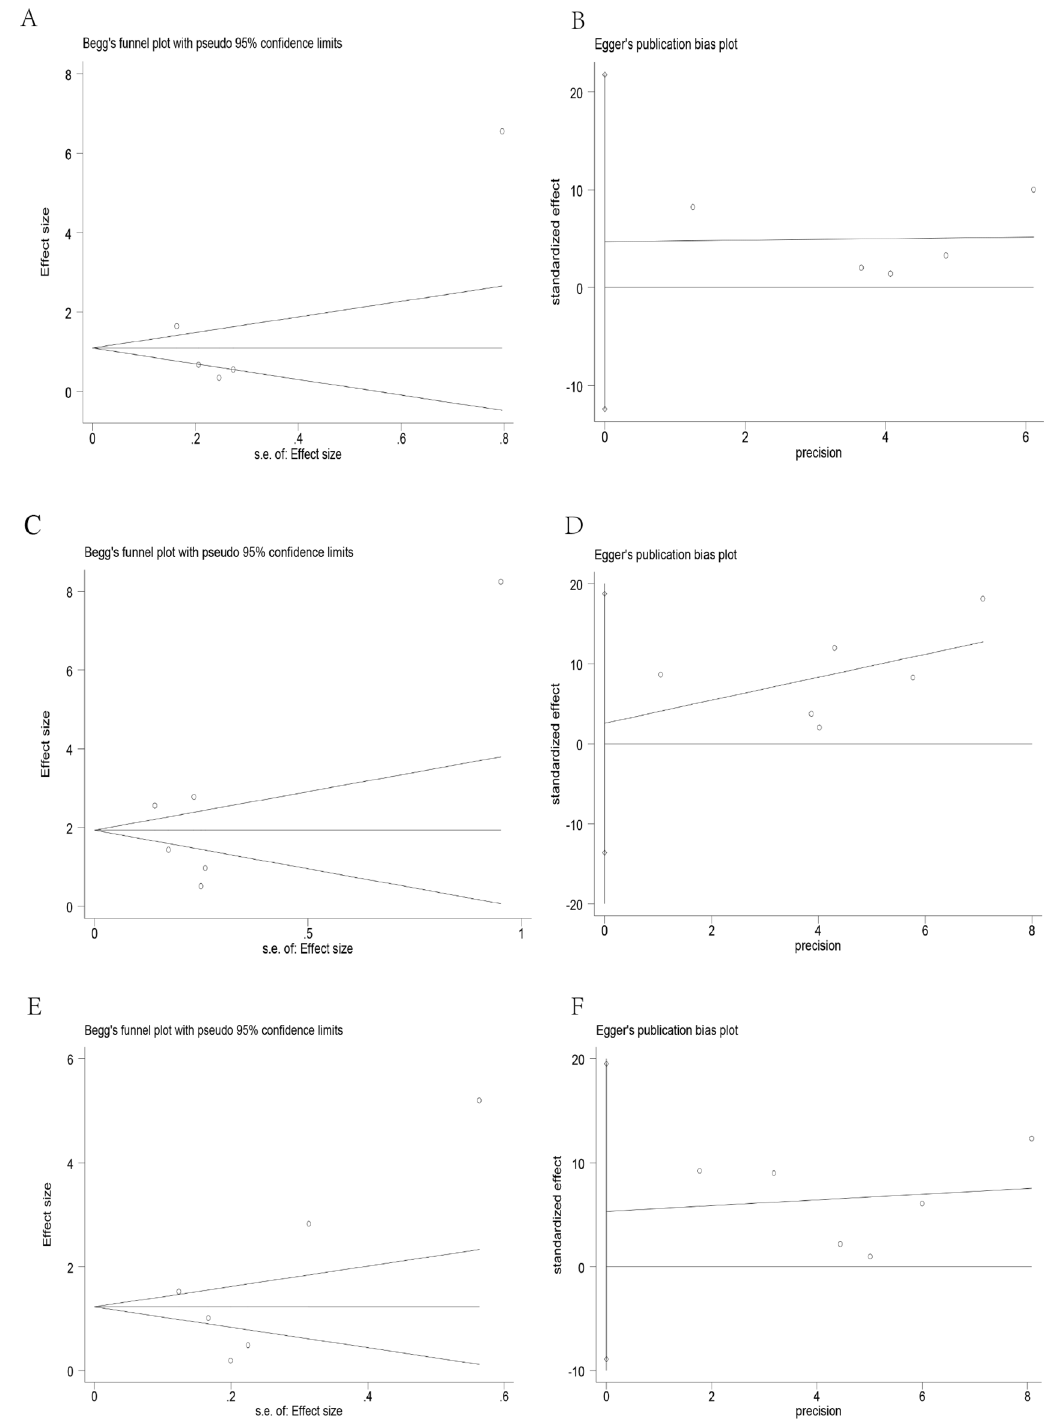
Figure 5. Publication bias tests of all included studies (( A,B ) a funnel of Begg’s test and Egger’s test of FN group and healthy controls: ( C,D ) a funnel of Begg’s test and Egger’s test of FS group and healthy controls; ( E,F ) a funnel of Begg’s test and Egger’s test of FS group and FN